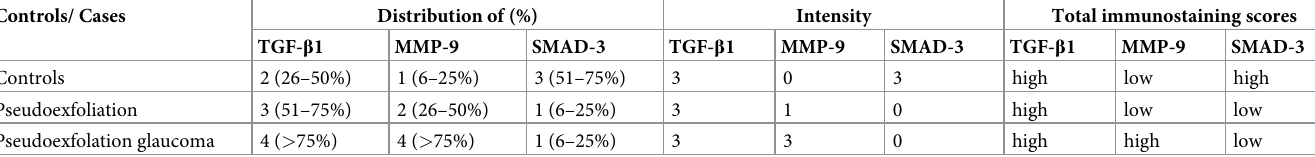
Table 2. The immunostaining scores of TGF β 1, MMP-9 and SMAD-3 in human tenonscapsule. Controls/ Cases